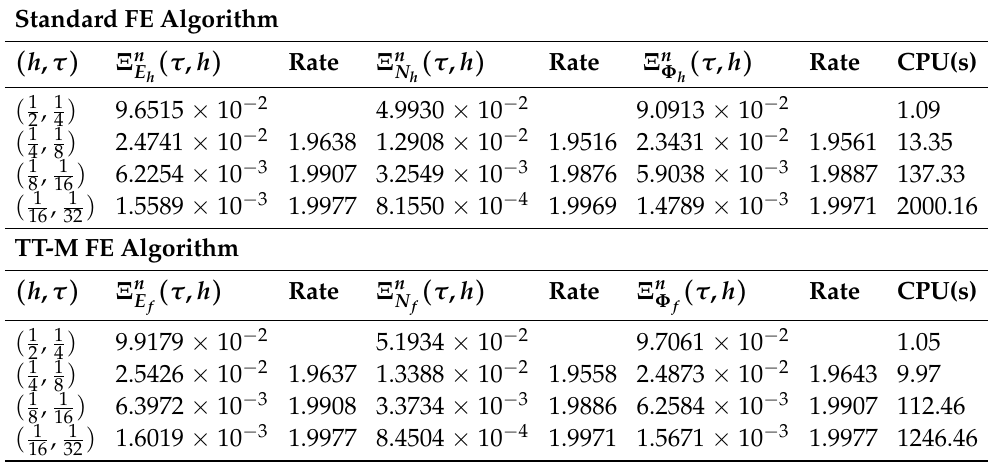
h and τ C = 4 τ . 2